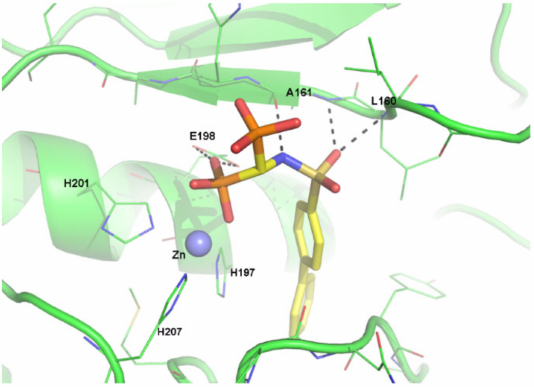
Figure 2. X-ray crystal structure of the ML 115 in complex with matrix metalloproteinase (MMP)–8. Hydrogen bonds between ML 115 and MMP–8 are shown as grey, dashed lines. The zinc ion is represented as a violet sphere. (PDB CODE: